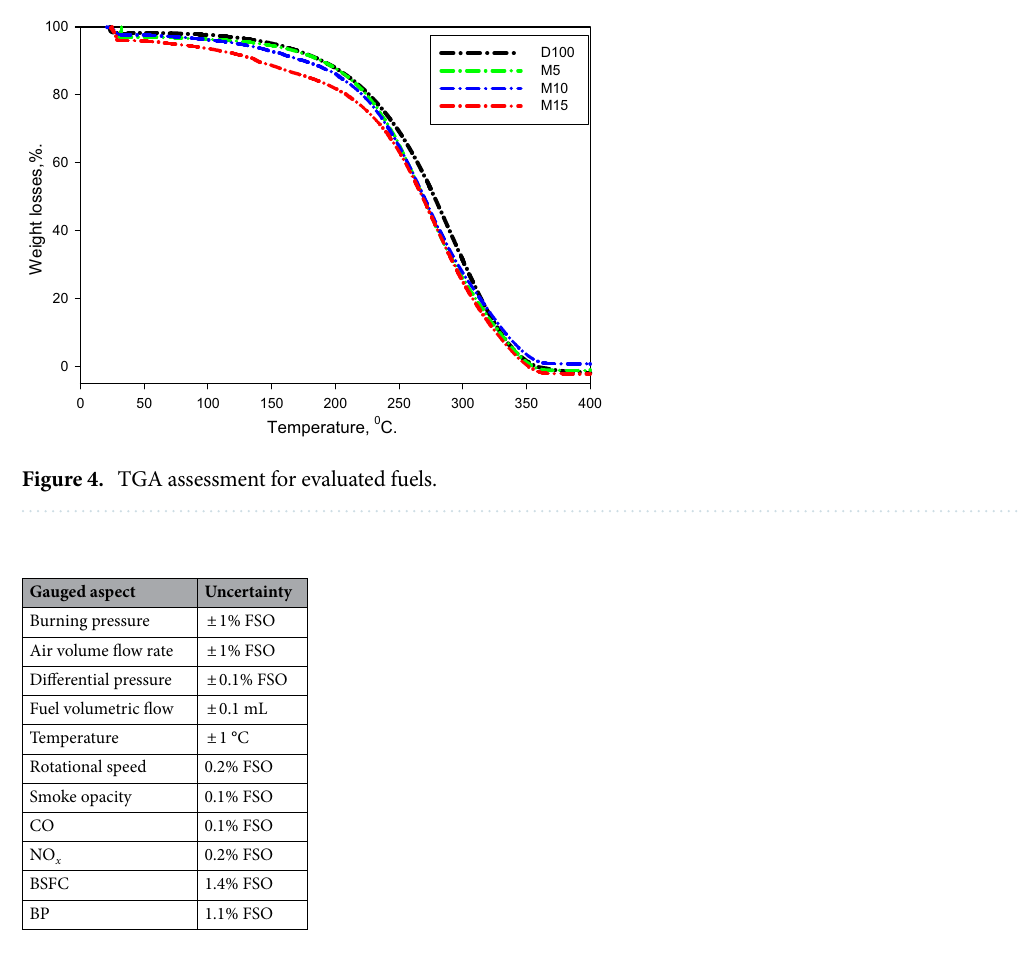
Table 4. Uncertainty